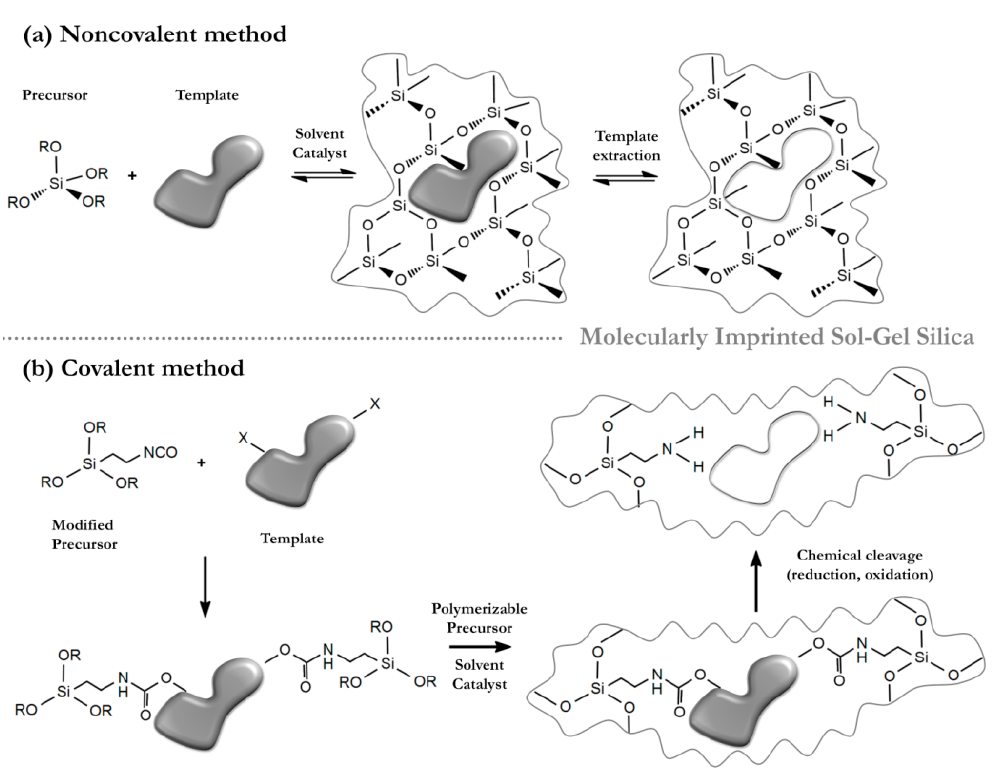
Figure 2. Molecular imprinting methods in sol-gel process ( a ) noncovalent templating and ( b ) covalent templating [70] (permission obtained for reproduction).